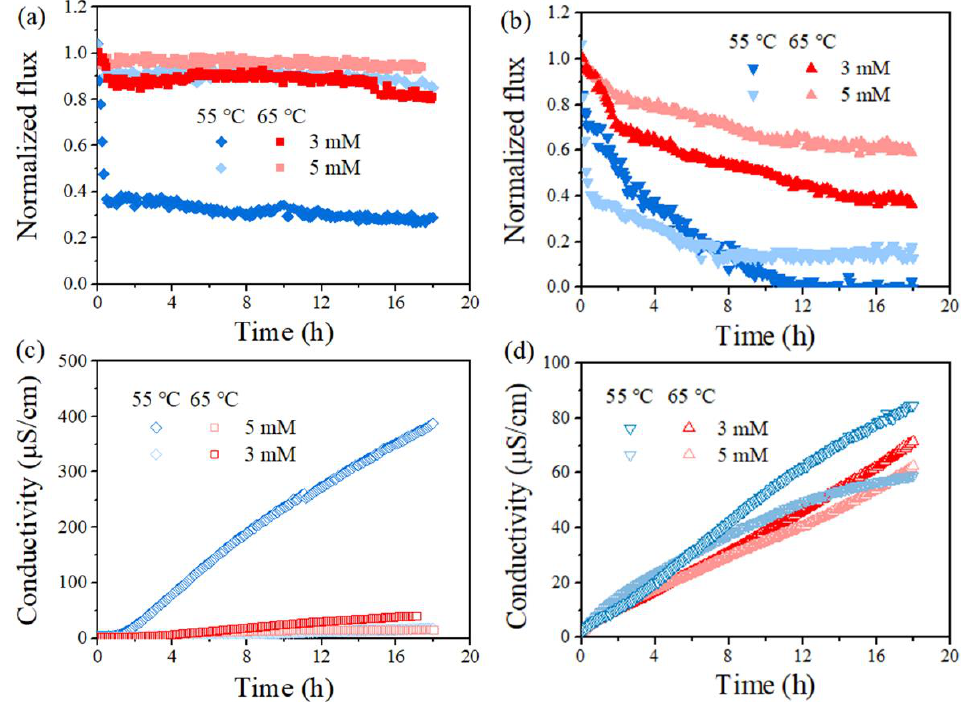
Figure 5. Effect of temperature (T f = 65 °C and T f = 55 °C) on normalized, time-dependent permeability for PVDF ( a , c ) and PTFE ( b , d ) in the presence of 0.5 mM SDS ( a , c ) and 0.8 mM SDS ( b , d ). Normalization was on the basis of permeate flux for feed without SDS yet of 5 g/L NaCl, which was 20.51 ± 1.81 for the PVDF and 19.54 ± 1.52 kg/m 2 /h for PTFE at T f –T p = 50 °C, and 14.61 ± 1.26 kg/m 2 /h for PVDF and 14.52 ± 1.72 for PTFE at T f –T p = 40 °C, respectively.